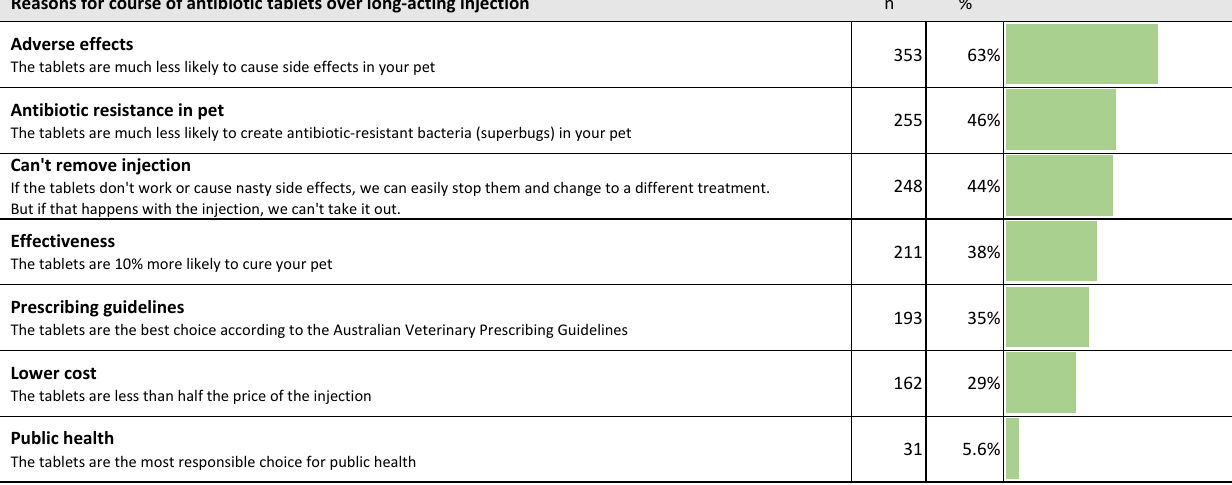
Figure 11. Pet owner preferences for reasons to give a course of antibiotic tablets rather than a single, long-acting antibiotic injection. Respondents could select up to three statements that they found convincing, so the total is